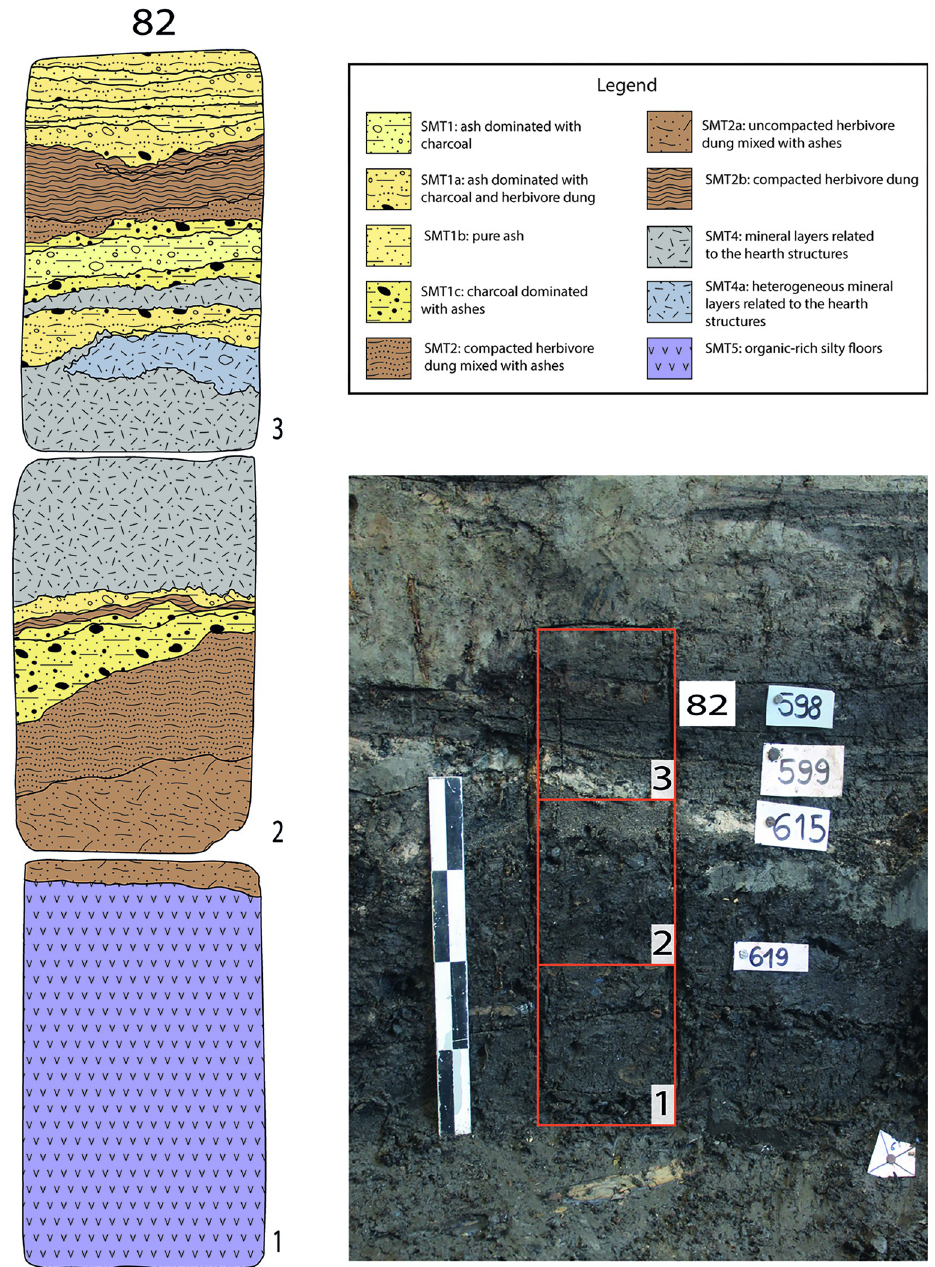
Fig 13. Sampling location of OPP 80–81 and interpretation of the vertical accretion of structure E. Right: detail of Fig 5C, showing the position of monolith OPP 82. Three thin sections were obtained from OPP 80 (82–1, 82–2, 82–3). Left: interpretation of the thin sections, with a SMT assigned to each